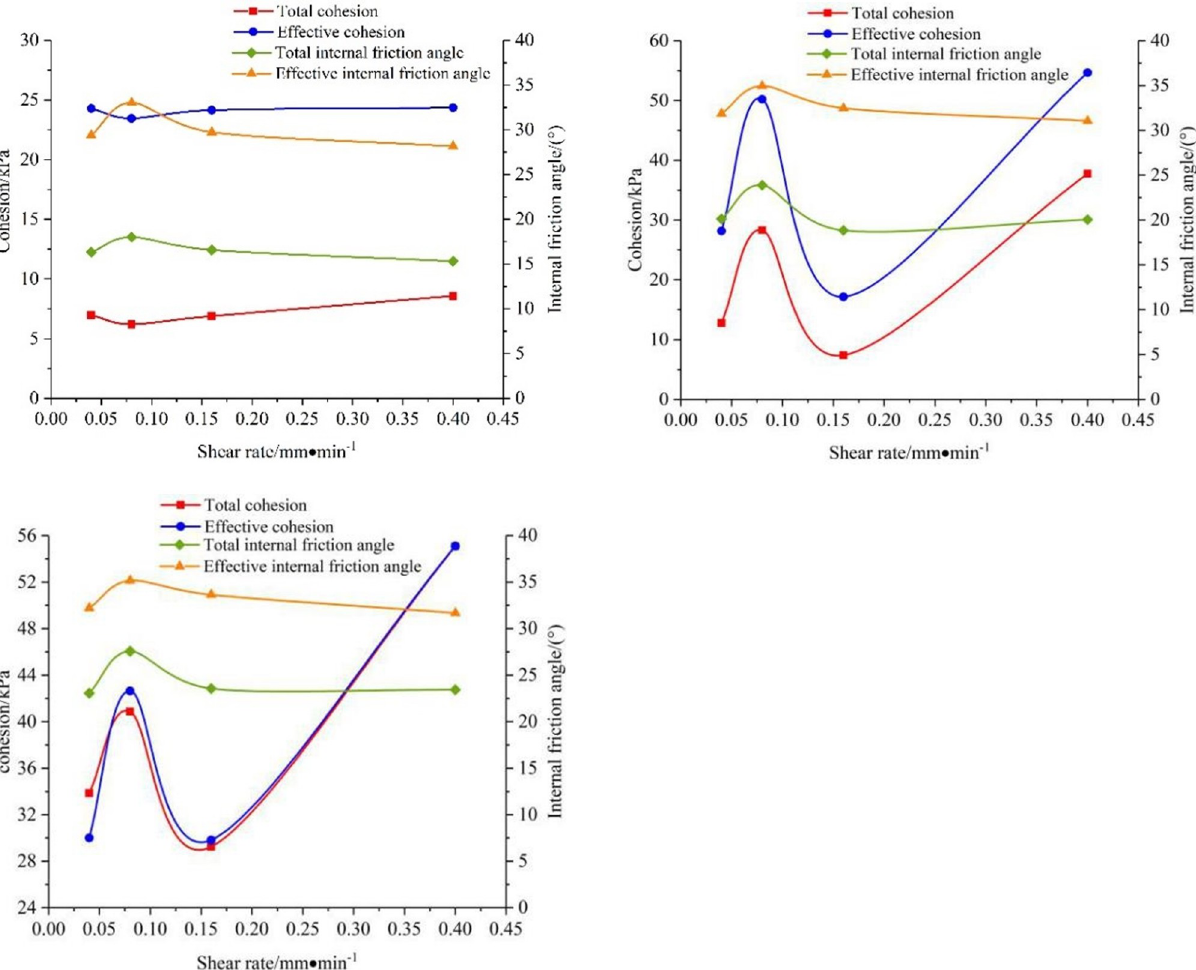
Fig 10. Relationship between cohesion, internal friction angle and a shear rate of saturated remolded soil samples. (a) ρ d = 1 . 5 g/cm 3 . (b) ρ d = 1 . 6 g/cm 3 . (c) ρ d = 1.7 g/cm 3